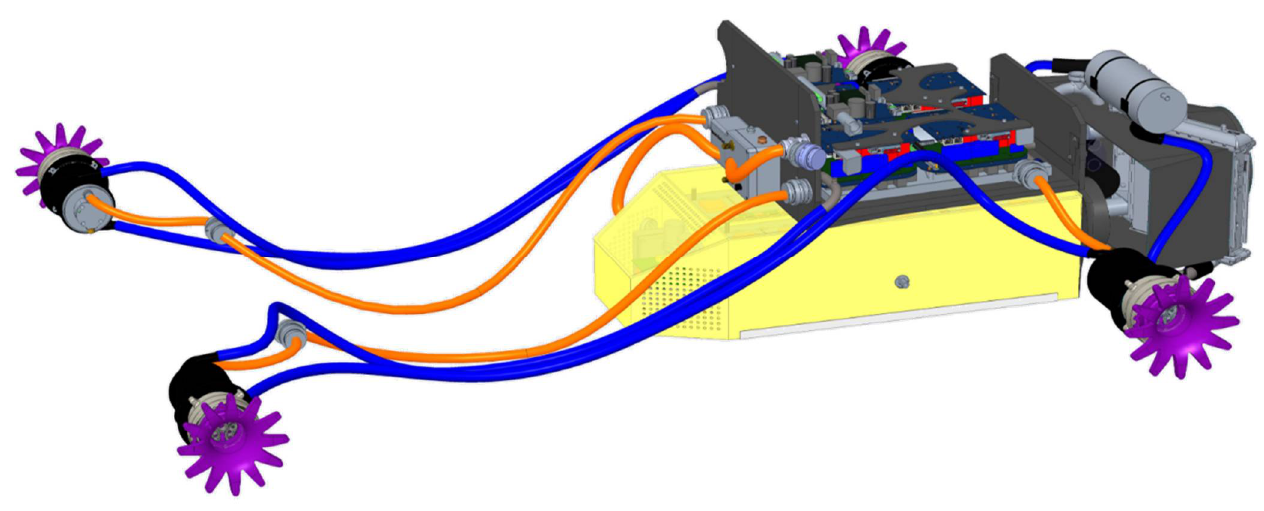
Figure 1. Drive-train of the electric race car with four motor packages, the accumulator, inverter and radiators.